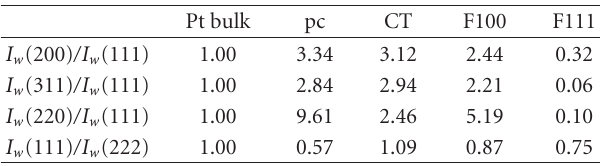
Table 2: Weighted ratio for the reflections in pc Pt, CT Pt, Pt F100, and Pt F111